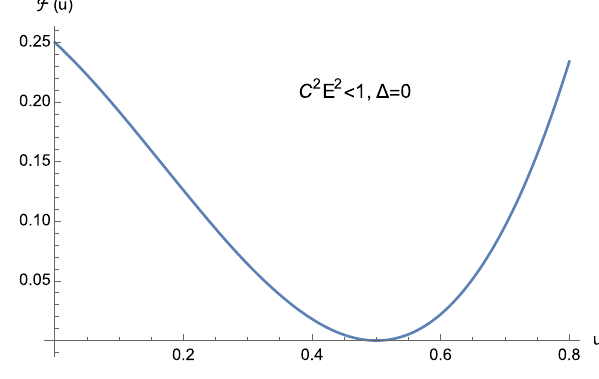
Fig. 5 The positive roots of Eq. (2.20) when C 2 E 2 < 1 and (cid:9) > 0